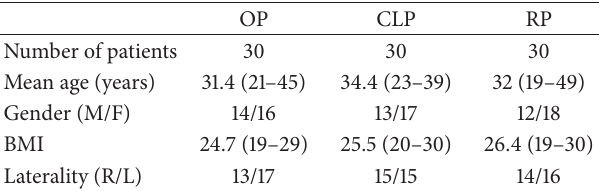
Table 1: Clinical profile of patients in three